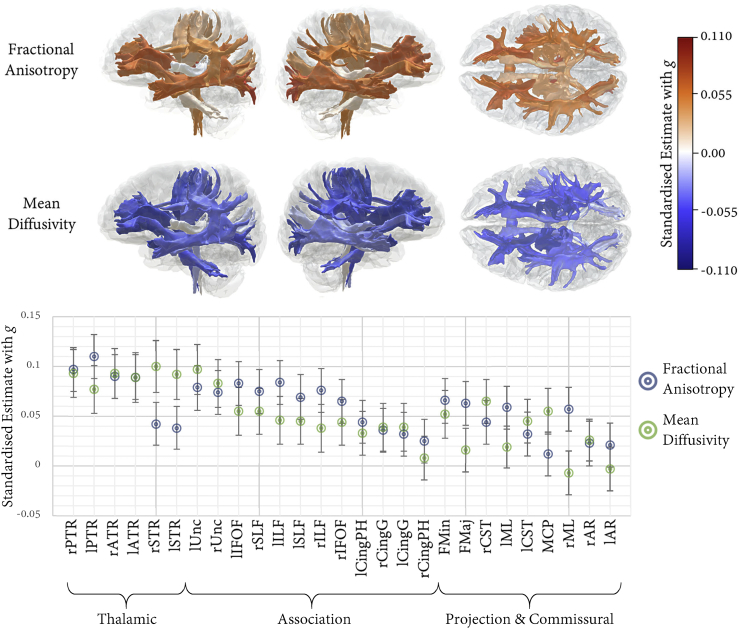
Associations between white matter tract-specific microstructure and g. Tabulated results also reported in Tables S6 and S7. Top panel shows left and right lateral and superior views of the white matter tracts of interest, heatmapped according to association magnitude. Lower panel displays the association magnitudes sorted by tract class and then from strongest to weakest (based on the average of FA and MD), with 95% CIs; MD valences have been flipped to aid visual comparison.